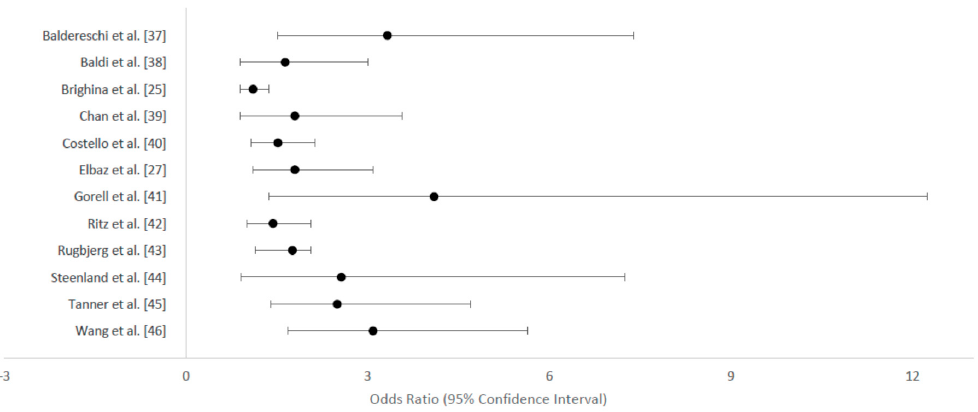
Figure A3. Forest Plot for Agricultural Studies.